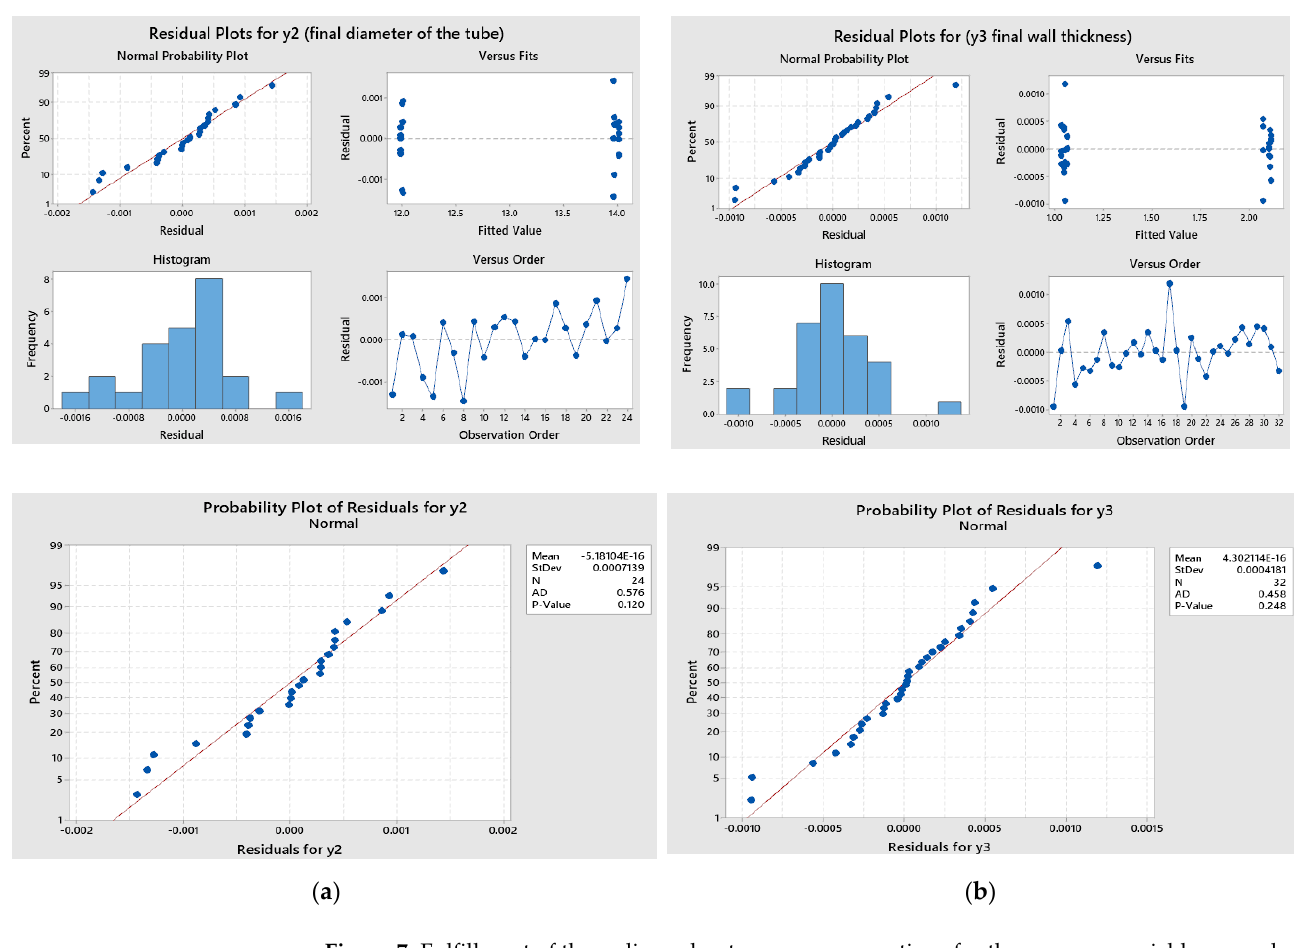
Figure 7. Fulfillment of the ordinary least squares assumptions for the response variables y 1 and y 2 : ( a ) residual plots for the response variable y 2 (final diameter of the tubes); ( b ) residual plots for the response variable y 3 (final wall thickness of the tube).